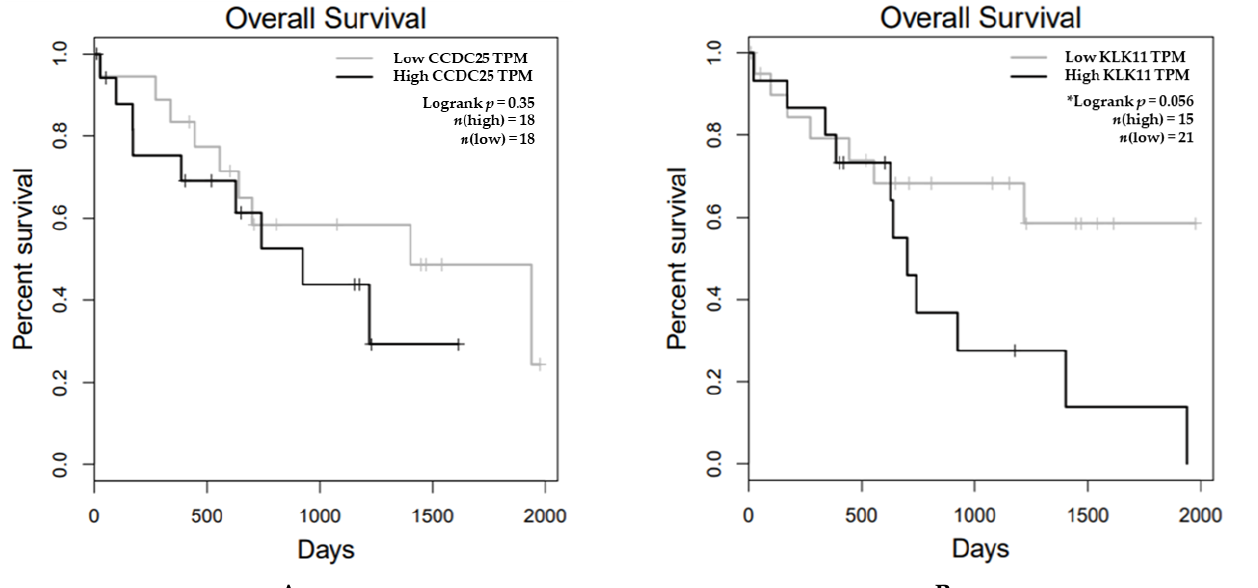
Figure 7. Kaplan–Meier survival curve analysis of CCDC25 and KLK11 mRNA expression levels and overall survival time of the samples obtained from GEPIA. The curves show overall survival of CCA patients having high expression (black line) and low expression (grey line). The survival time of CCA patients between low- and high-expression groups of ( A ) CCDC25 and ( B ) KLK11. * Statistical significance ( p < 0.1).